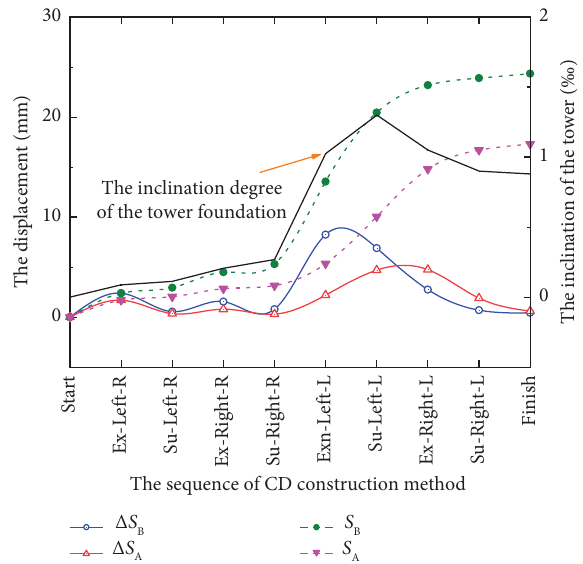
Figure 10: Te settlement and inclination law of tower foundation corresponding to diferent construction